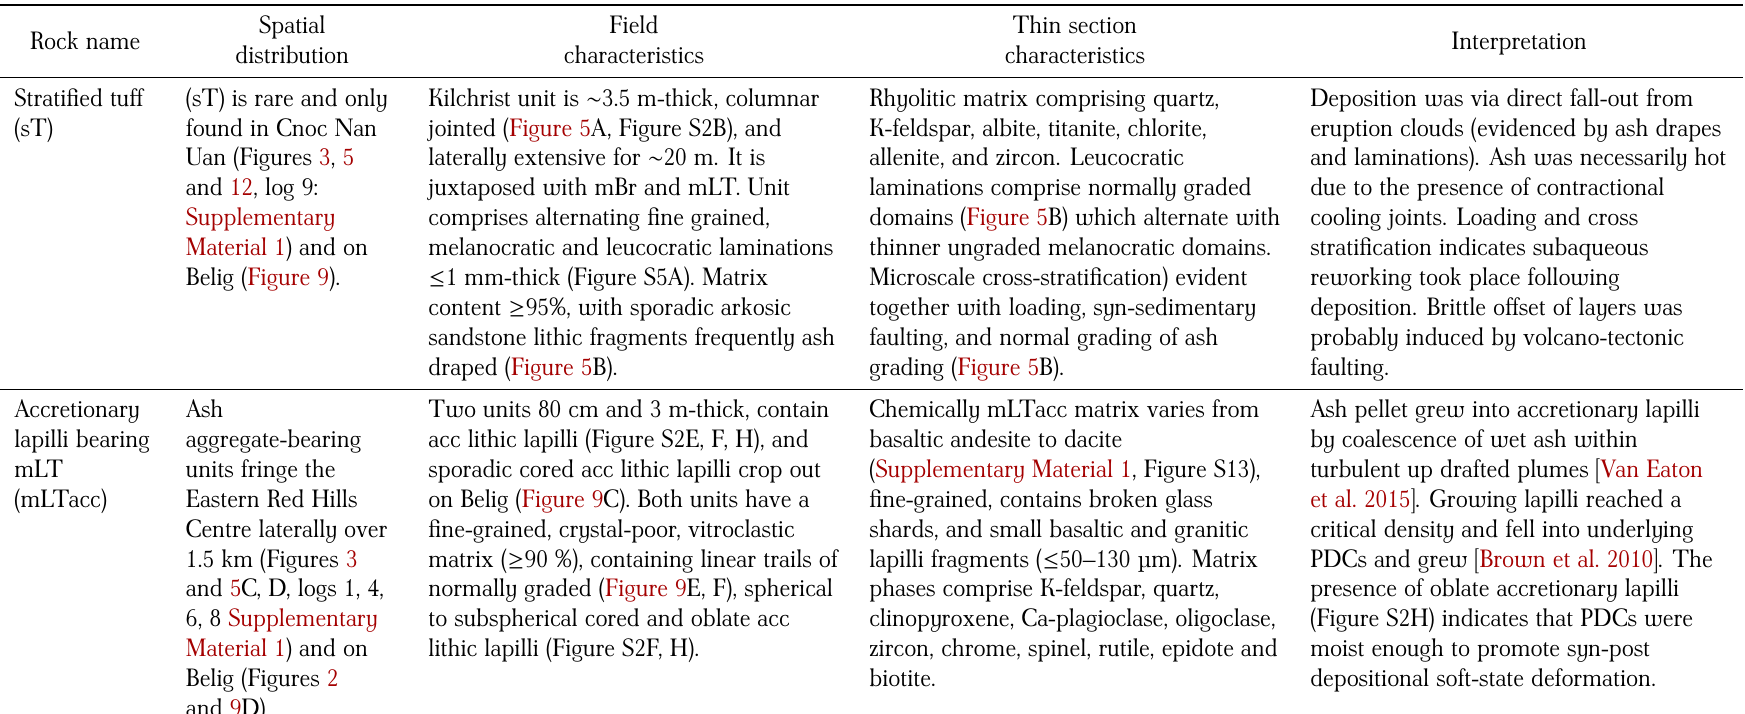
Table 2: Stratified tuff (sT) and accretionary lapilli–bearing massive lapilli tuff (mLTacc) of the